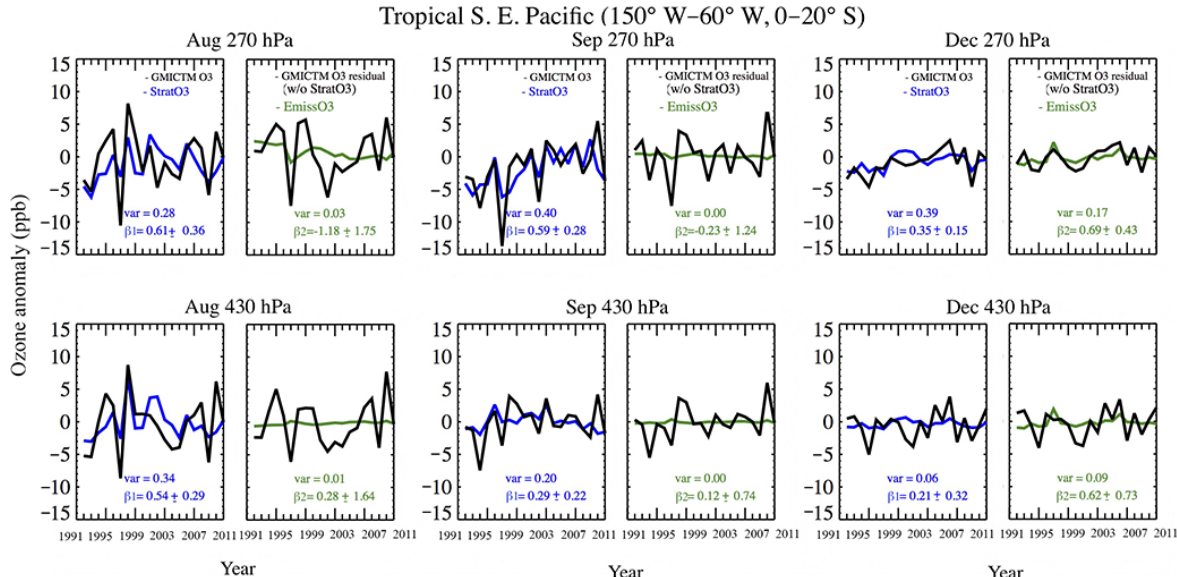
Figure 17. The multi-regression results of simulated ozone anomalies over the tropical southeastern Pacific region relying on two predictor variables: StratO 3 (blue) and EmissO 3 (green) at 270 and 430hPa. Three panels show results from August (left), September (middle), and December (right) from 1992 to 2011. Each panel contains two columns. The left column of each panel compares the anomalies of StratO 3 (blue) and simulated ozone mixing ratio (black) from the GMI-CTM model at 270 and 430hPa. The right column compares the simulated O 3 residual after removing the regression from StratO 3 (black line) and EmissO 3 (green line) at these two levels. EmissO 3 is calculated from the difference of simulated ozone between the run with yearly-varied emission and the run with constant emission. Unit for y axis is parts per billion (ppb). The variance explained by each predictor (var), regression coefficient ( β) , and its 95% confidence level are labeled in each